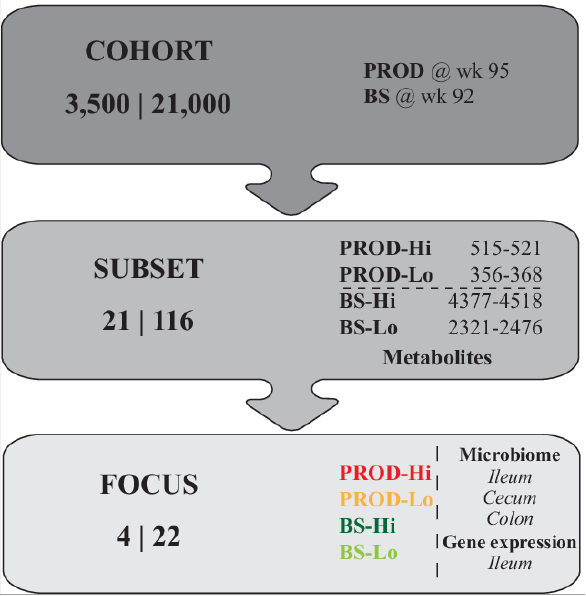
Figure 1. General experimental design. At the left side of each box the number of cages and hens are indicated (e.g., COHORT 3500 cages and 21,000 hens). At the right side, characteristics are shown. Top box: when the production (PROD) and breaking strength (BS) were measured. Middle box: the range of high and low PROD, PROD-Hi and PROD-Lo, respectively. As well as high and low BS, BS-Hi, and BS-Lo, respectively, metabolites were measured. The bottom box: microbiome and gene expression of specific intestinal segments that were measured.